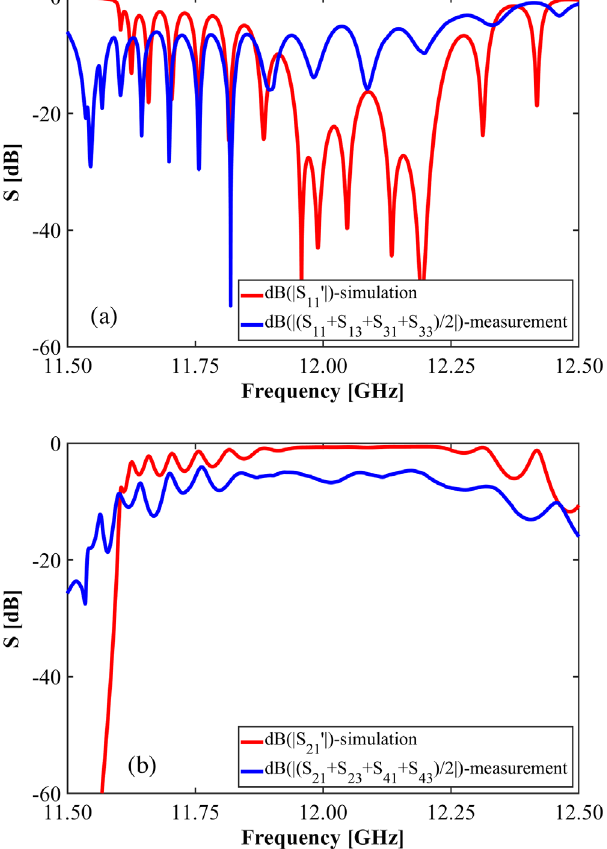
II).FIG. 17. Comparison between simulated and measured S-parameters [(a) S 0 11 and (b) S 0 21 ] for two end-part prototypes connected with an aluminum waveguide. FIG. 19. Comparison between simulated and measured S- parameters [(a) S 0 11 and (b) S 0 21 ] for the full-assembly